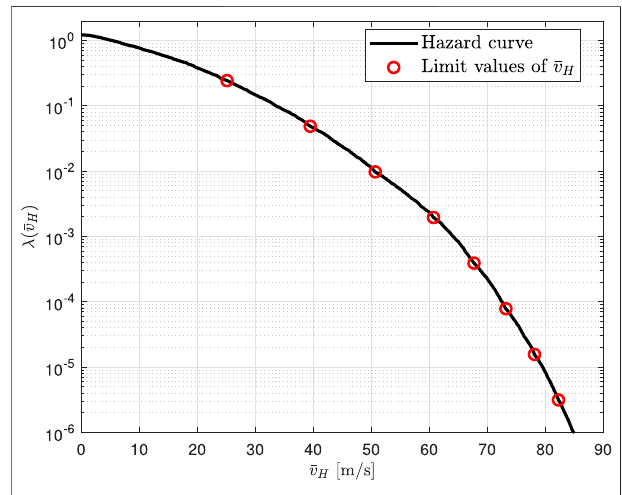
FIGURE 3 | The estimated hurricane hazard